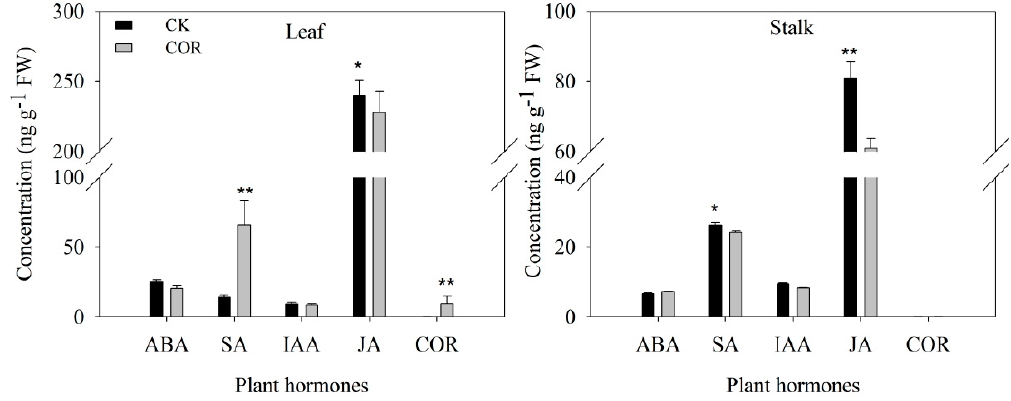
Figure 3. Effects of COR on endogenous hormone content in stalks and leaves of maize inbred line B73 plants in greenhouse. CK: control treatment; COR: 10 µmol L -1 COR treatment; ABA: abscisic acid; SA: salicylic acid; IAA: auxin; JA: jasmonic acid; COR: coronatine. * and ** indicate significance at the 0.05 and 0.01 probability levels.